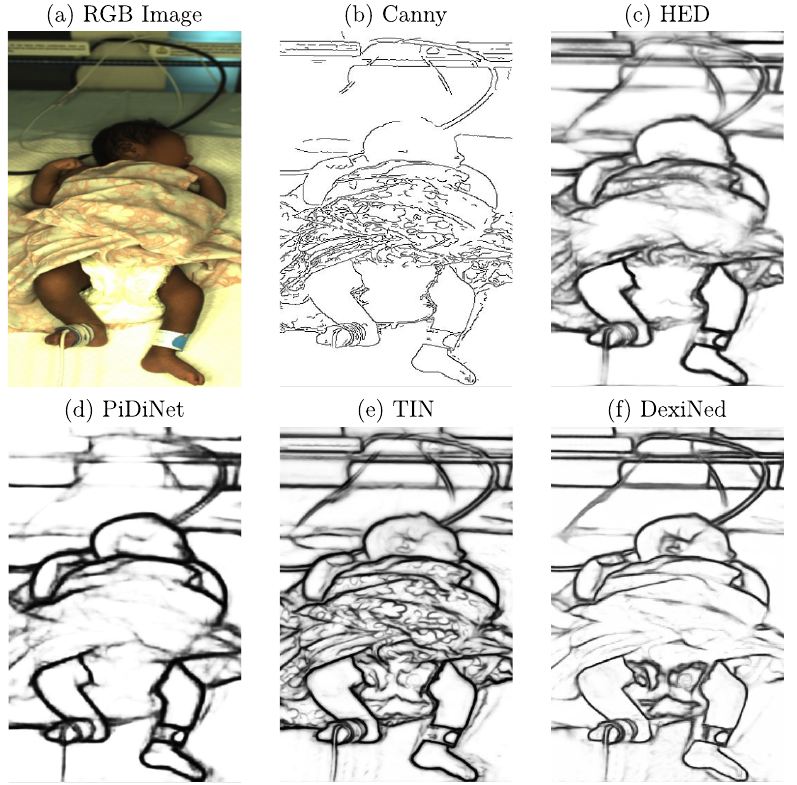
Figure 3. Example RGB frame and corresponding images of several used edge